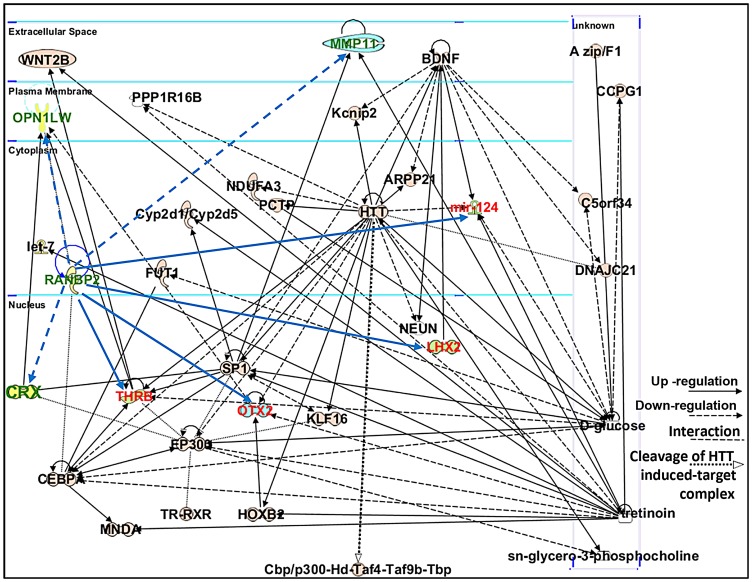
Connectivity map of a gene network linked to Ranbp2 functions.Ingenuity pathway analysis (IPA) of factors modulated by loss of Ranbp2 identified a top network implicated in “Cellular and Nervous System Development and Function, and Carbohydrate Metabolism” (score of 22). Dashed and solid blue arrows were added manually to the network to reflect the down-regulation and up-regulation of genes (shown in green and red), respectively, observed first upon ablation of Ranbp2 in cone photoreceptors as identified by this work. Note that Crx and Mpp11 expressions underwent first transient down-modulation at P7 followed by their sustained up-regulation. Legend: ARPP21, cAMP-regulated phosphoprotein, 21 kDa; BDNF, Brain derived neurotrophic factor; C5orf34, chromosome 5 open reading frame 34; cbp, CREB-binding protein; CCPG1, cell cycle progression 1; CEBPA, CCAAT/enhancer-binding protein alpha; CRX, Cone-rod homeobox protein; Cyp2d1/Cyp2d5, cytochrome P450, family 2, subfamily d, polypeptide 1/cytochrome P450, family 2, subfamily d, polypeptide 5; DNAJC21, DnaJ homolog subfamily C member 21; EP300, also called p300, E1A binding protein p300; FUT1, fucosyltransferase 1; HOXB2, homeobox B2; HTT or Hd, huntingtin; Kcnip2, Kv channel-interacting protein 2; KLF16, Kruppel-like factor 16; let-7, Let-7 microRNA precursor; LHX2, LIM/homeobox protein2; mir-124, microRNA 124; MMP11, Matrix Metalloproteinase 11; MNDA, myeloid cell nuclear differentiation antigen; NDUFA3, NADH dehydrogenase (ubiquinone) 1 alpha subcomplex, 3; NEUN, Feminizing Locus on X-3, Fox-3, or Hexaribonucleotide Binding Protein-3; OPN1LW, long-wave-sensitive opsin (cone pigment); OTX2, orthodenticle homeobox 2; PCTP, Phosphatidylcholine transfer protein; PPP1R16B, protein phosphatase 1, regulatory subunit 16B; sn-glycero-3-phosphocholine, 2,3-dihydroxypropyl 2-(trimethylazaniumyl)ethyl phosphate; SP1, Sp1 transcription factor; THRB, thyroid hormone receptor, beta; Taf4, TAF4 RNA polymerase II, TATA box binding protein (TBP)-associated factor; Taf9b, TAF9B RNA polymerase II, TATA box binding protein (TBP)-associated factor; Tbp, TATA box binding protein; TR, Thyroid Hormone Receptor; RXR, Retinoic acid receptor; tretinoin, all-trans retinoic acid or ATRA; WNT2B, wingless-type MMTV integration site (WNT) family2B.